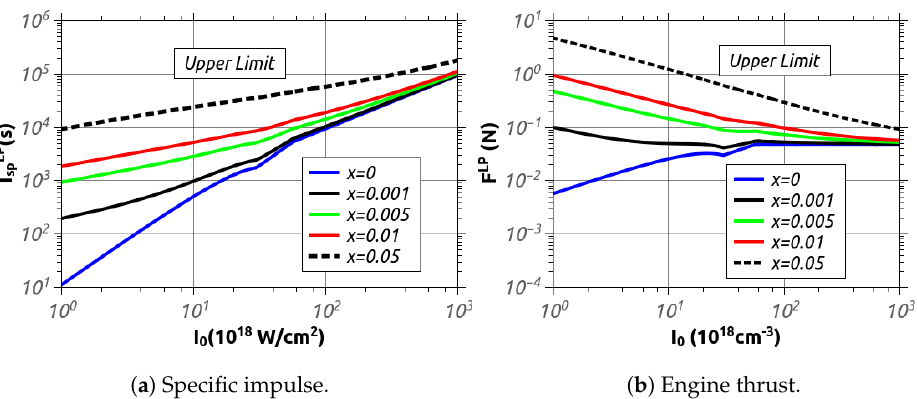
Figure 6. Specific impulse and engine thrust calculated for a C 6 + target as a function of laser intensity. Parameters are fixed by d = 5 µ m, ρ = 1 g/cm 3 and τ L = 100 fs. The considered angular spread are ϕ = 30° and ϕ (cid:48) = 60°, while 1 − (cid:101) = 90%. The function χ ≤ 0.05 is used as a fixed parameter. In subplot ( b ) the engine thrust is calculated at fixed pulse energy of ε L = 5 × 10 3 J with a laser repetition rate of ν L = 1